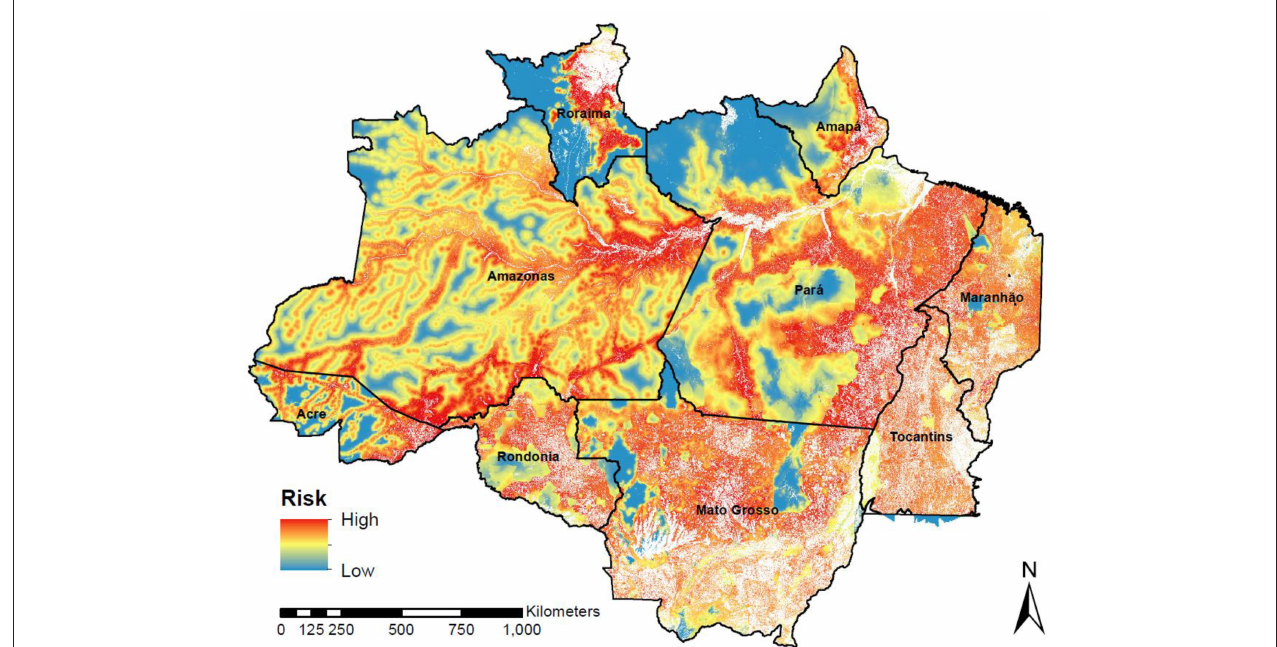
FIGURE 3 | Likelihood of deforestation informed by the 2000–2004 spatial pattern of forest loss observed in the Brazilian Legal Amazon region.